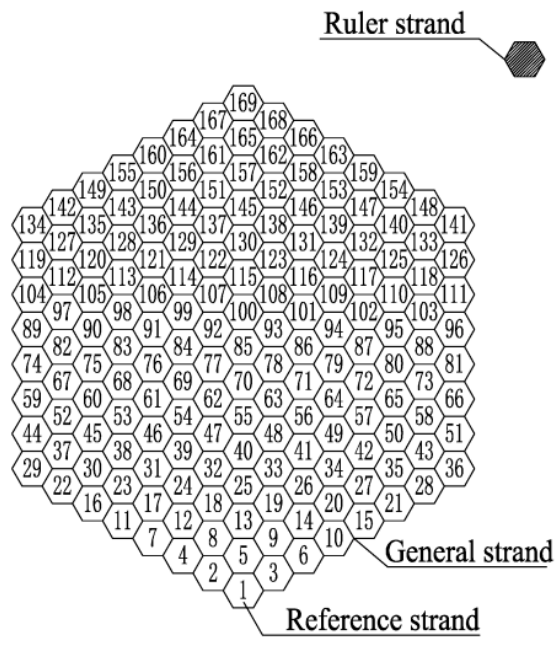
Figure 10. Space position of strands.